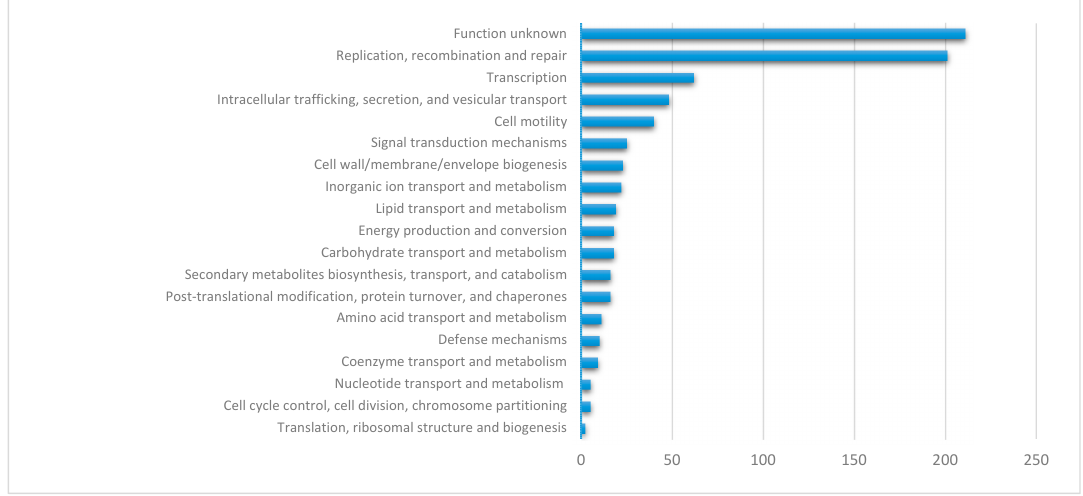
Figure 5. Functional annotation of proteins encoded by the crpP -harboring ICEs.